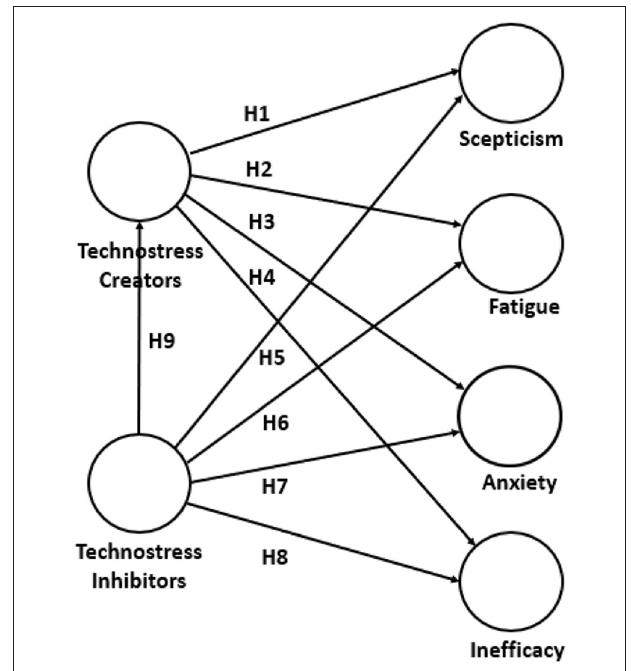
FIGURE 1 | The conceptual model under